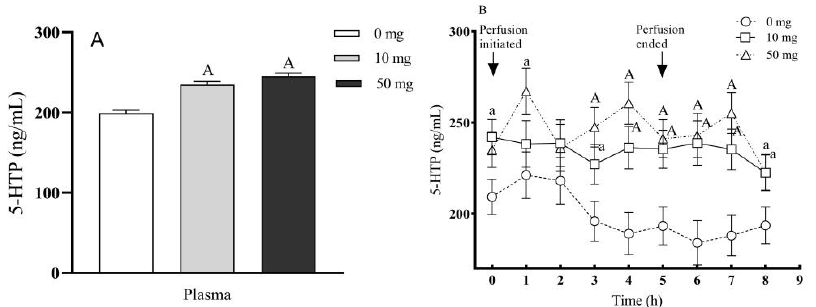
Figure 3. Effects of different doses of 5-HTP duodenal perfusion on circulating blood 5-HTP con-